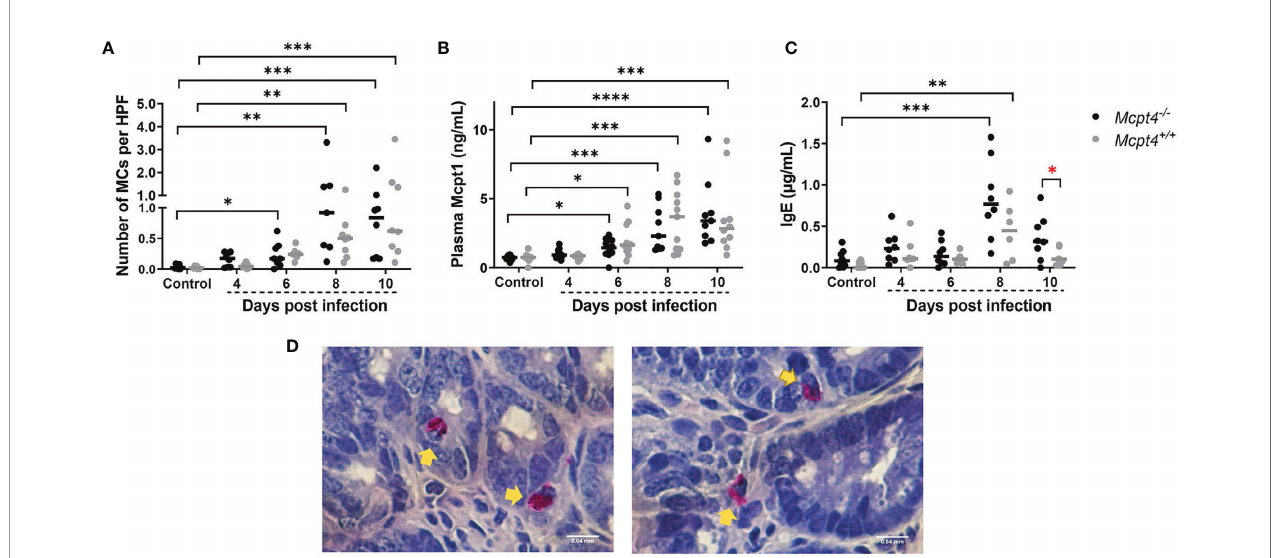
FIGURE 2 | Plasmodium y. yoelii 17XNL-infected Mcpt4 -/- mice exhibited earlier infection-associated increases in ileal MCs and higher circulating levels of IgE relative to infected Mcpt4 +/+ mice. (A) Numbers of ileal MCs per high-powered fi eld (HPF) from naphthol AS-D chloroacetate esterase (NASDCE) stained sections from uninfected control mice and infected Mcpt4 -/- and Mcpt4 +/+ mice. (B) Plasma MC protease 1 (Mcpt1) concentrations as determined by ELISA. (C) Plasma IgE concentrations as determined by ELISA. (D) Representative stained MCs (pink cells indicated by yellow arrows) in ileum of Mcpt4 -/- (left) and Mcpt4 +/+ (right) mice at 8 days PI. Number of MCs and IgE levels in plasma were determined for biological replicates 1 and 2 (n=8 mice per group per time point), while plasma Mcpt1 levels were determined for the three replicates (n=11 mice per group per time point). Data were analyzed with the Kruskal-Wallis test followed by Dunn ’ s multiple comparison for each time point versus control or between Mcpt4 -/- and Mcpt4 +/+ mice at speci fi c time points; lines represent the median. P values ≤ 0.05 were considered signi fi cant. *P ≤ 0.05, **P ≤ 0.01; ***P ≤ 0.001, ****P ≤